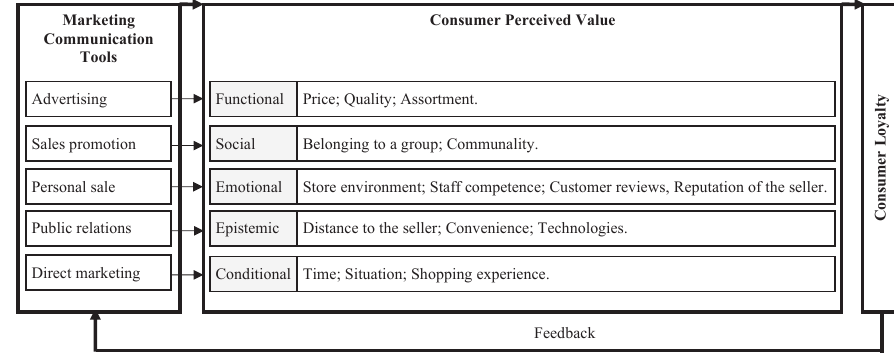
Fig. 1 – Theoretical model of creating value for consumer through marketing communication tools. Source: own